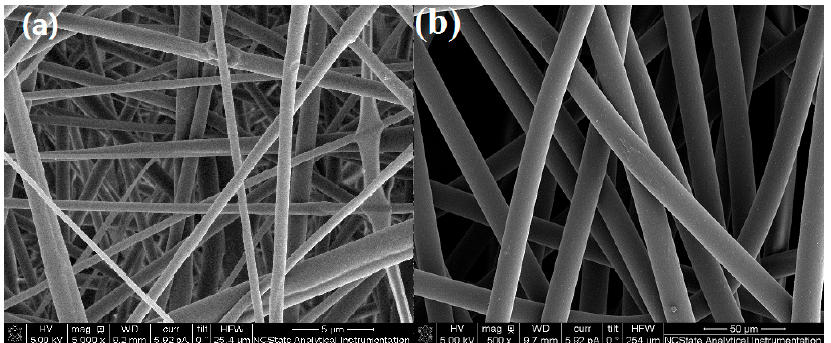
Figure 1. Nanofibers using electrospinning using roller collector, ( a ) nylon 6,6 fabric consisting of nanofibers with average diameter 505 nm ( σ = 152.5 nm); and ( b ) melt spun microfibers (Cerex Spectramax ® nylon 6,6) with diameter 17.3 μ m ( σ = 0.86 μ m).